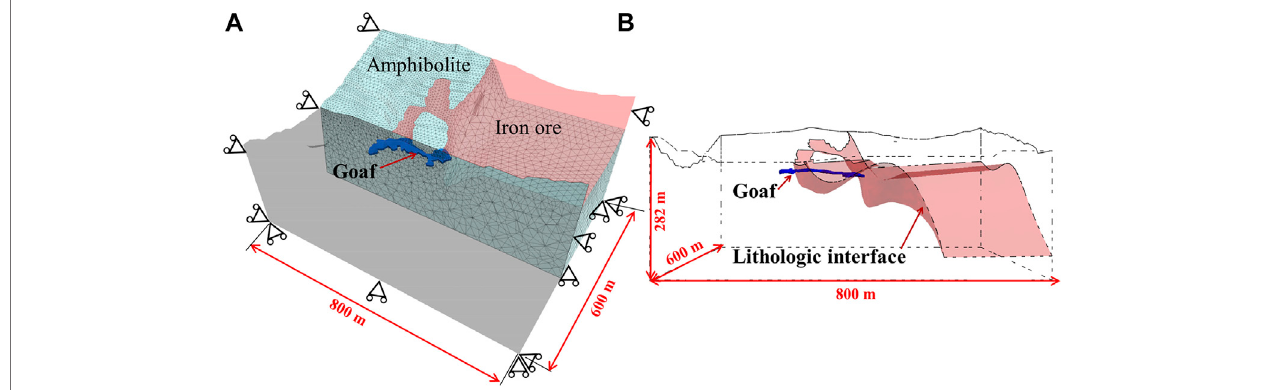
FIGURE 7 | Numerical model. (A) Relative position between goaf and model boundary. (B) Relative position of the interface between goaf and lithology.